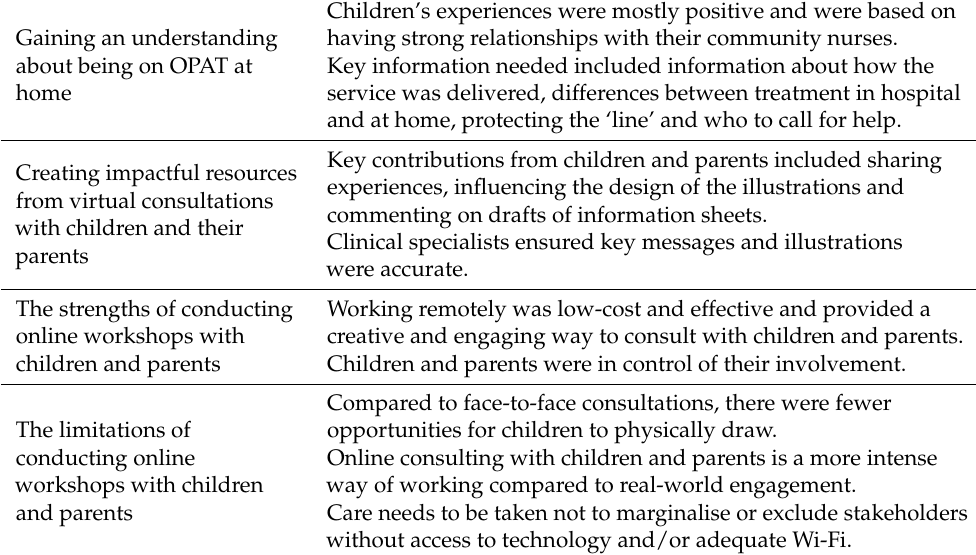
Table 1. Overview of key information learned from the consultation